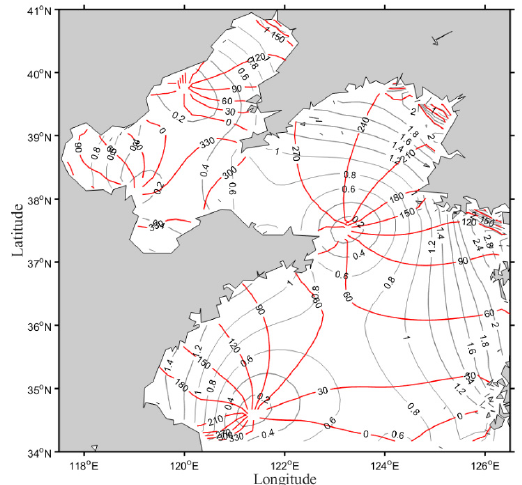
Figure 14. Cotidal chart for the M 2 constituent in the BYS obtained by TPF scheme. Gray line denotes the co-amplitude line (m), red line denotes the co-phase line (°).